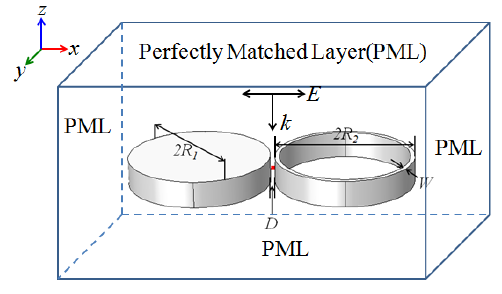
Figure 5. Schematic of the disk-ring nanostructure.